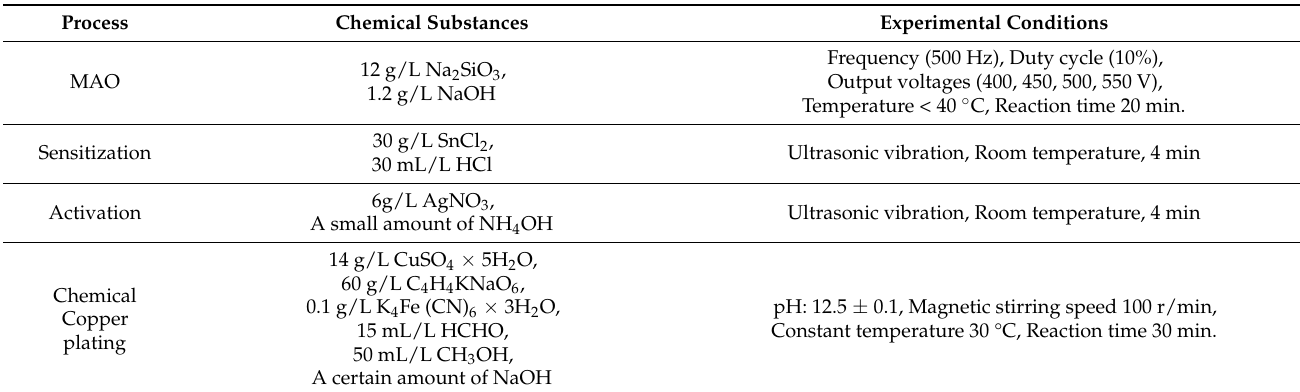
Table 1. Condition parameters for MAO, pretreatment, and electroless copper plating onto the aluminum surface. Process